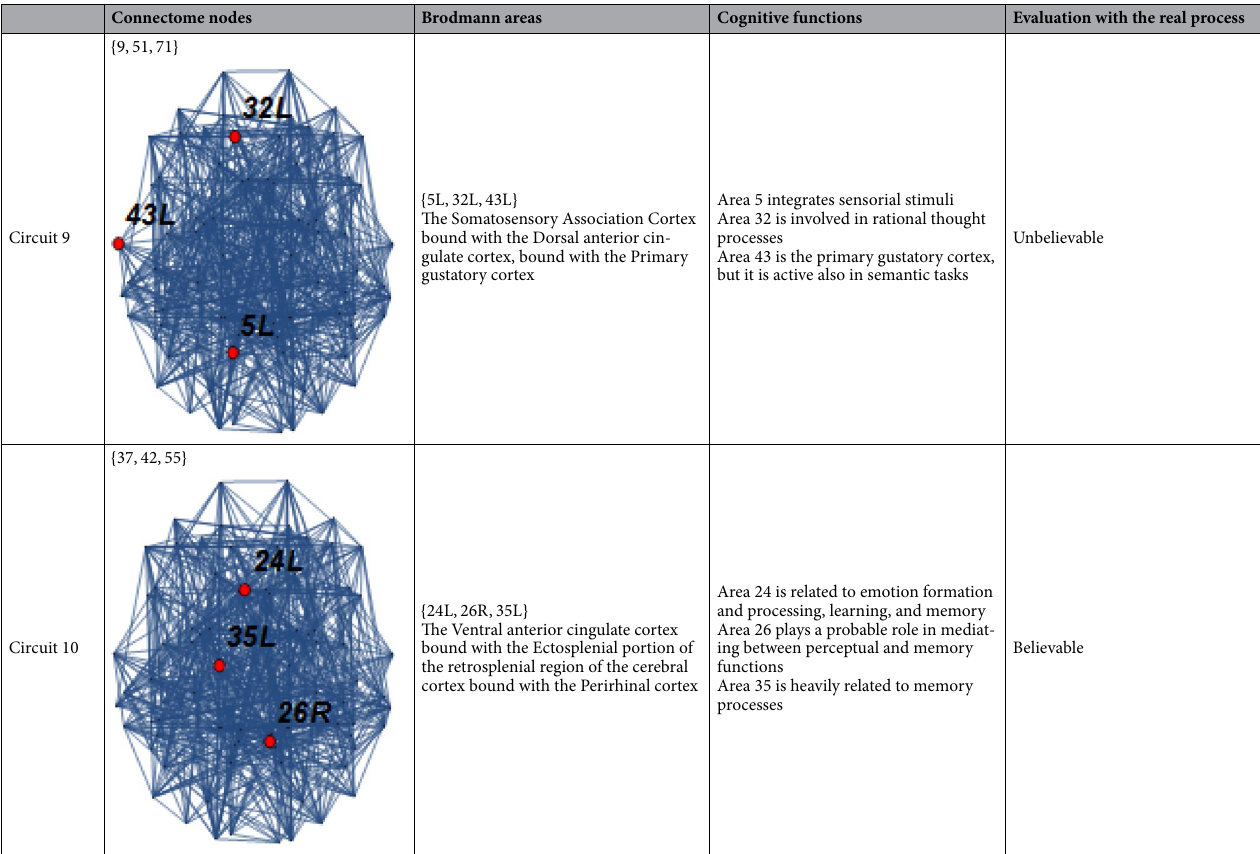
Table 5. Evaluation results about the emerging circuits for the simulation chosen as example. It is reasonable to think that most of the circuits are congruent with the simulated cognitive